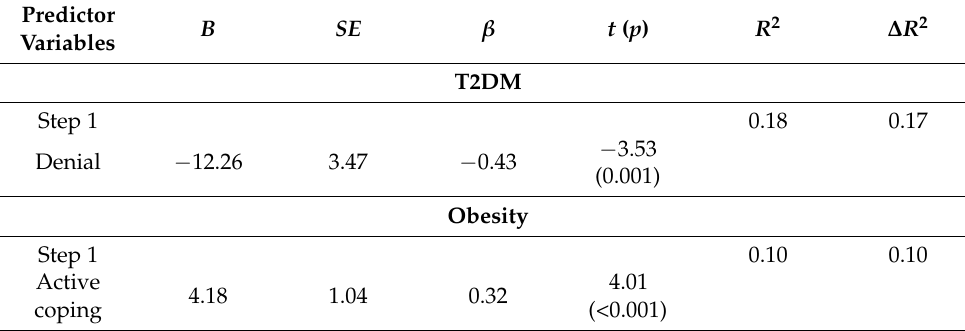
Table 6. Coping Strategies as Predictors of Physical Component Summary